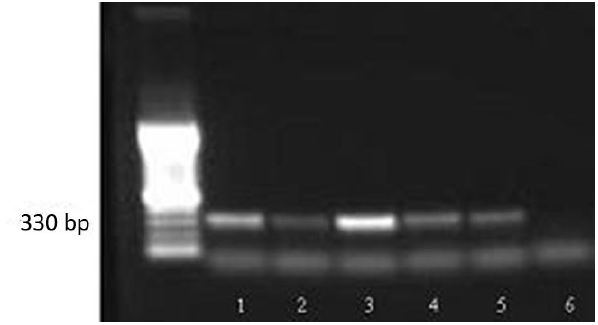
Figure 3. Polymerase chain reaction (PCR) analysis for the detection of T. cruzi DNA. Sample 1, heart; sample 2, liver; sample 3, lung; sample 4, kidney; sample 5, positive control; sample 6, negative